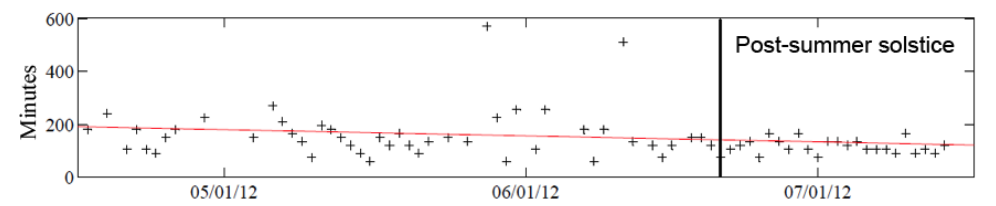
Figure 8. Daily replenishing time during the melt season. Each marker indicates the time taken by daily radiative inputs to compensate for nightly radiative losses during the previous night. This calculation provides an estimate of the amount of time required each day to return the snowpack to the water output phase. The summer solstice is highlighted with a vertical